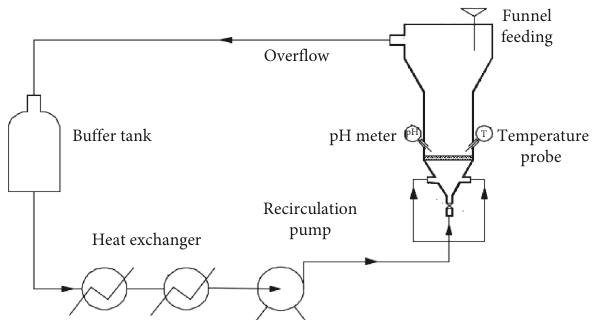
Figure 3: The experimental flow chart of the fluidized crystalli- zation